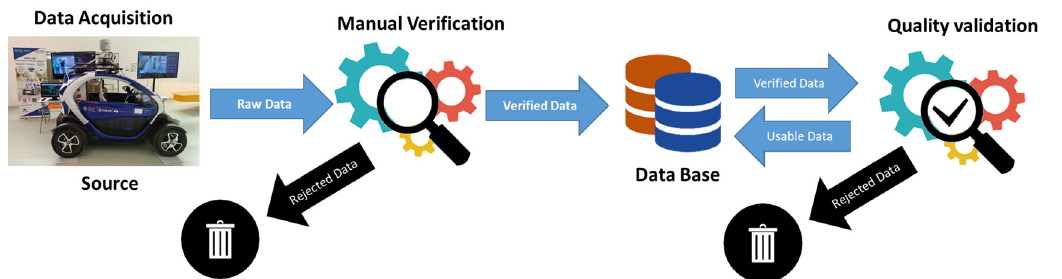
Figure 4. Verification